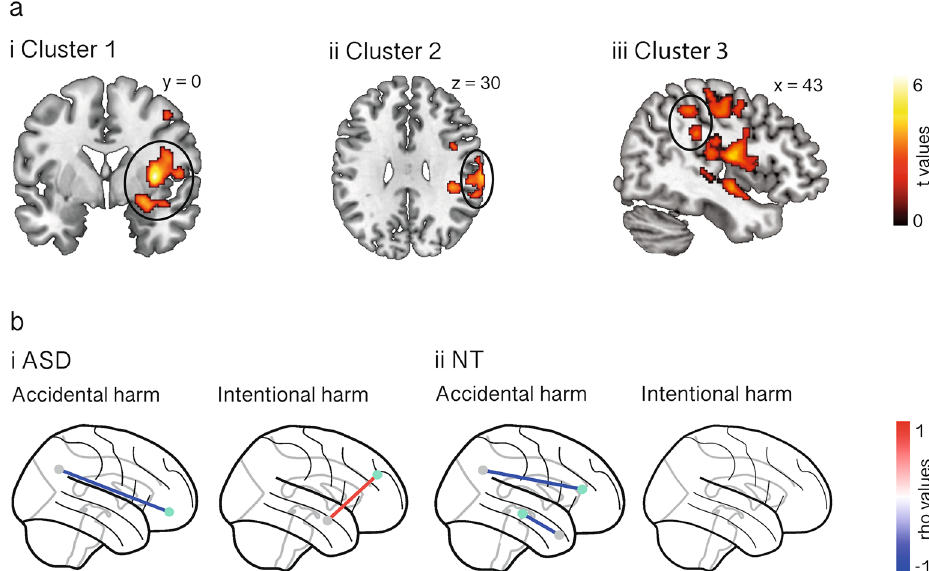
Figure 3. fMRI results. ( a ) Task-related results. Clusters spanning fronto-temporo-limbic (i) and precentral, postcentral/supramarginal, and posterior superior temporal (ii and iii) regions that showed a significant interaction effect between language and group ( p cluster-corr < 0.05). In the GL (vs. PL) condition, participants with ASD presented increased activation in cluster 1 for the accidental > intentional harm contrast ( p Bonferroni-corr = 0.04), and NT controls presented increased activation in the three clusters for the intentional > accidental harm contrast (all ps Bonferroni-corr ≤ 0.001). Compared to NT controls, participants with ASD presented increased activation in the three clusters in the GL-accidental harm condition (all ps Bonferroni-corr < 0.05). Contrast maps were created using SPM12 (https:// www. fil. ion. ucl. ac. uk/ spm/ softw are/ spm12/) and plotted in MRIcron (V1.0.20190902, https:// www. nitrc. org/ proje cts/ mricr on). Images are displayed in neurological convention. ( b ) Resting-state results. Functional connectivity associations with punishment ratings in the GL condition for ASD (i) and NT control (ii) groups. Punishment of accidental harms was negatively associated with medial prefrontal-angular gyrus connectivity in both groups, while punishment of intentional harms was positively associated with fronto-amygdala connectivity only in the ASD group (all ps unc < 0.001). Images were created using the Nilearn library for Python (V0.9.2, https:// nilea rn. github. io/ stable/ index. html). ASD autism spectrum disorder, NT